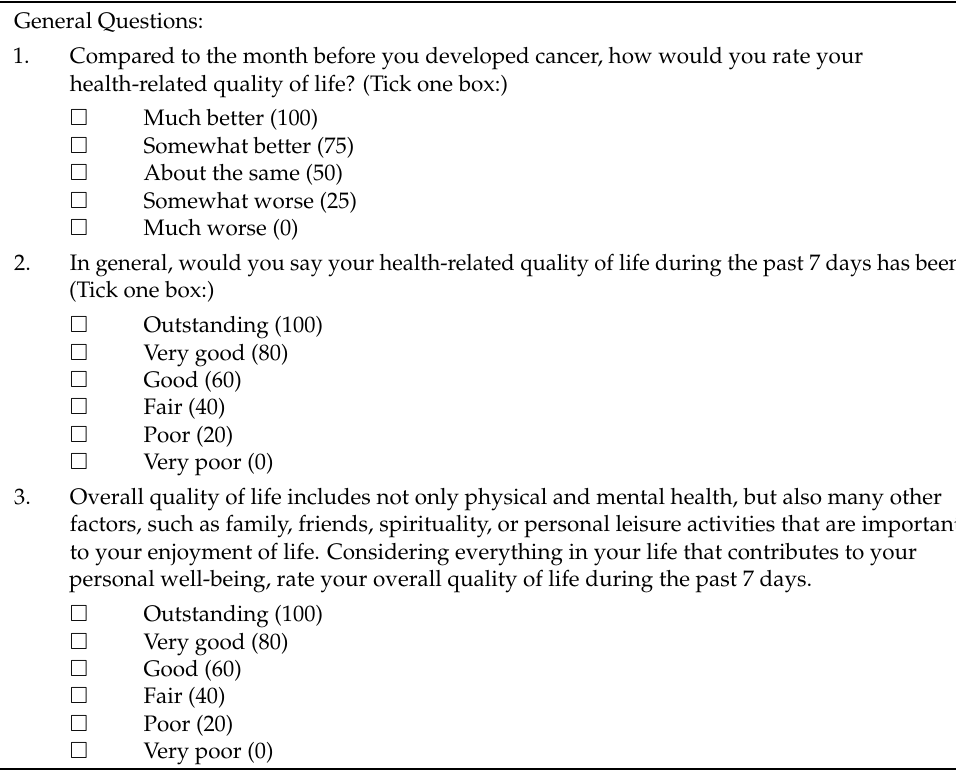
Table 3. Questionnaire’s global questions.